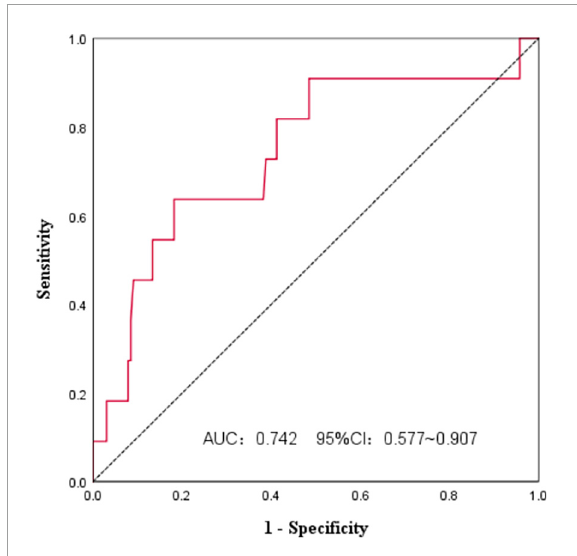
FIGURE1 The PNI optimal cut-off point for based on ROC